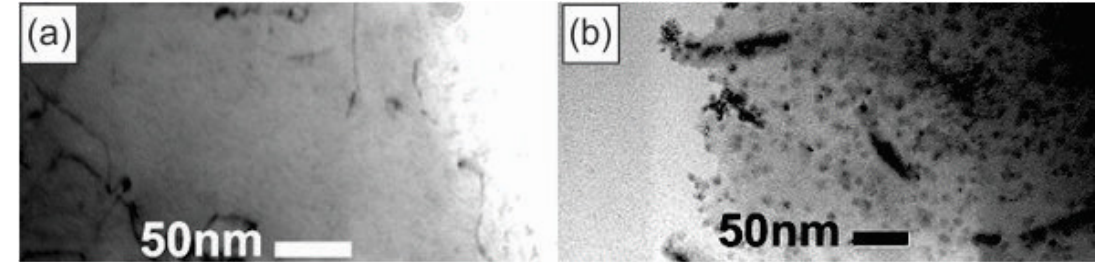
Figure 6. API X70 TEM micrographs: ( a ) as received pipeline steel TEM micrograph showing precipitation level, ( b ) 1 h aged steel specimen showing an increasing number and homogeneous precipitation distribution.